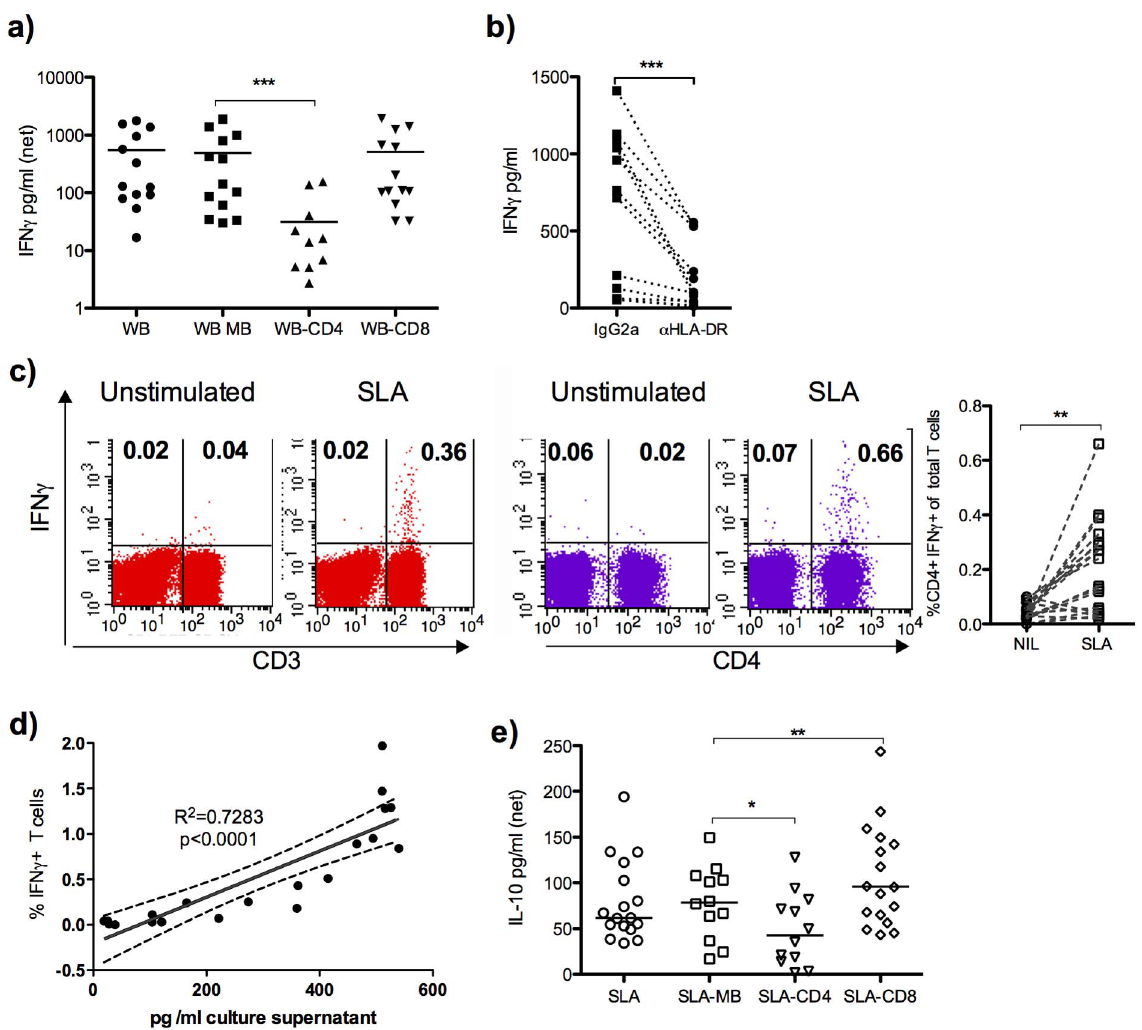
Figure 3. CD4 cells are necessary for and the source of IFN c in SLA stimulated WB from patients with active VL. IFN c production in SLA stimulated WB cultures of active VL patients following depletion of a) CD4 and CD8 positive cells. b) Effect of pan-HLA-DR blockade on SLA induced IFN c , compared to IgG2a isotype control treatment c) Intra cellular IFN c lymphocytes, following SLA stimulation of WB culture. The dot-plots to the left (red) show IFN c production in total gated lymphocytes and the dot-plots to the right (purple) show SLA induced IFN c in gated CD3 + cells. In the graph the frequencies of IFN c + CD4 + T cells are shown; combined results of three different experiments. d) Correlation between percentages of IFN c positive cells in gated CD3 + lymphocytes as determined by ICS and IFN c levels in WB supernatants following 24 hours of SLA stimulation. e) IL-10 levels in SLA stimulated WB supernatants following removal of CD4 and CD8 positive cells. Plasma was replaced with HI-FCS prior to incubation with MicroBeads or HLA-DR blockade, MB=mock treatment with magnetic beads directed against FITC. Each dot represents one sample. Net SLA response (e.g. stimulated minus unstimulated) samples are shown, if not otherwise indicated. Comparison between treatments was made using Wilcoxon matched paired test and statistical significances are indicated with *** p , 0.001, ** p , 0.01 and * p ,